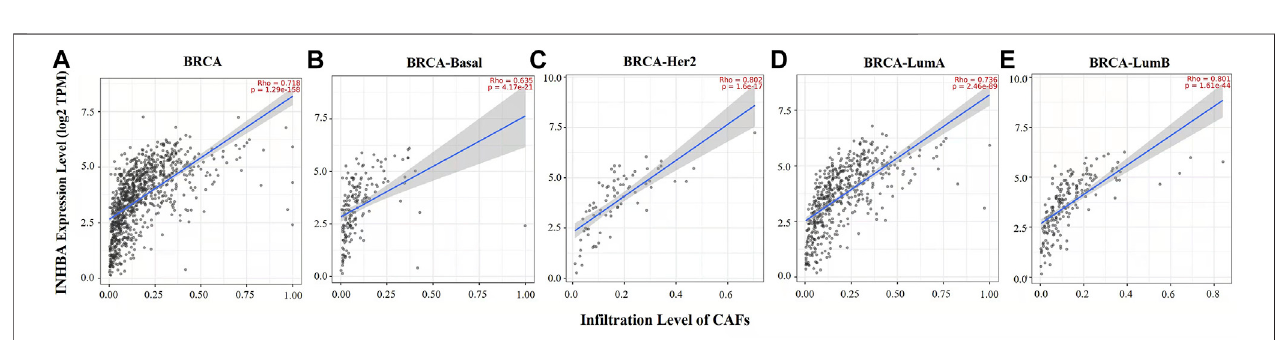
FIGURE 5 | Correlation between INHBA expression and abundance of CAFs in BRCA and subtypes (BRCA-Basal, BRCA-Her2, BRCA-LumA, and BRCA-LumB) analyzed by TIMER2.0. (A – E) INHBA expression had strongly positive correlations with CAF in fi ltration in BRCA ( n = 1,100), BRCA-Basal, BRCA-Her2 ( n = 82), BRCA- LumA ( n = 568), and BRCA-LumB ( n =